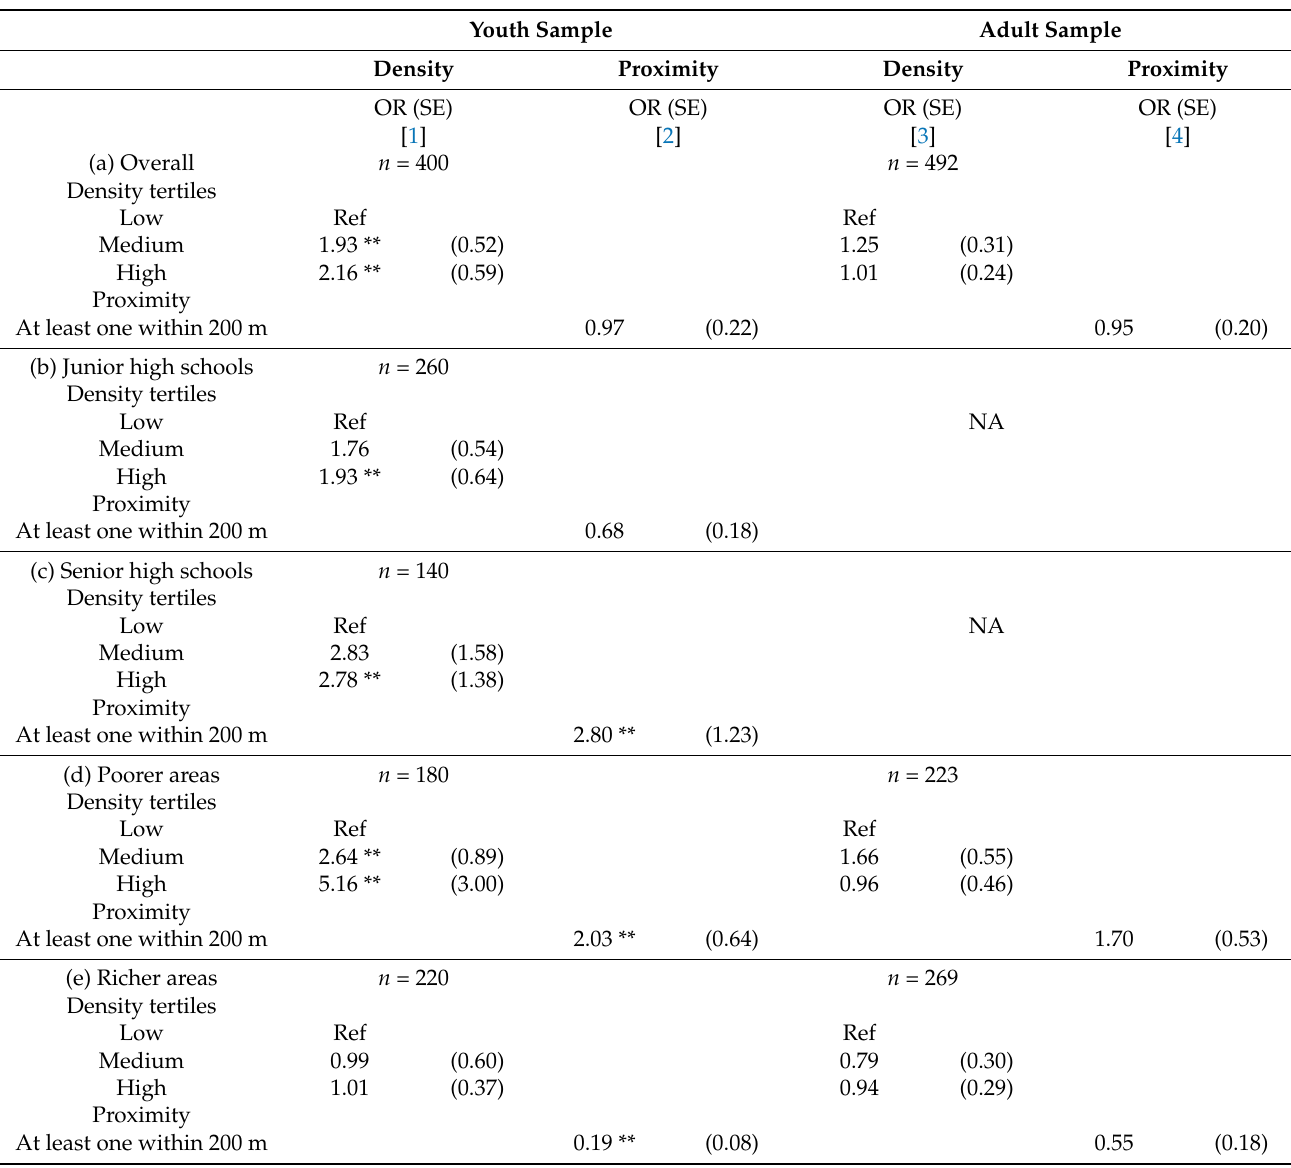
Table 2. Association between smoking behavior among youth and adults and measures of outdoor tobacco advert density and proximity in Semarang,